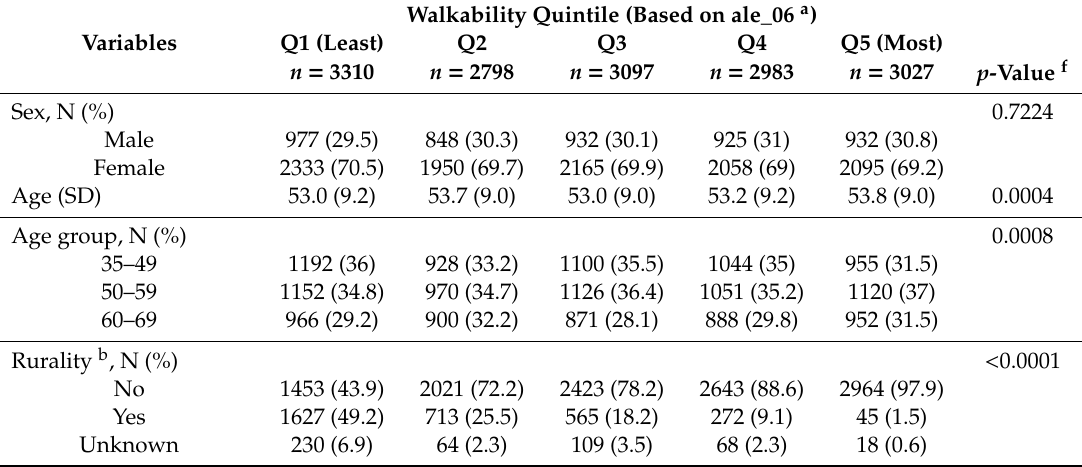
Table 1. Sociodemographic and health-related participant characteristics by walking